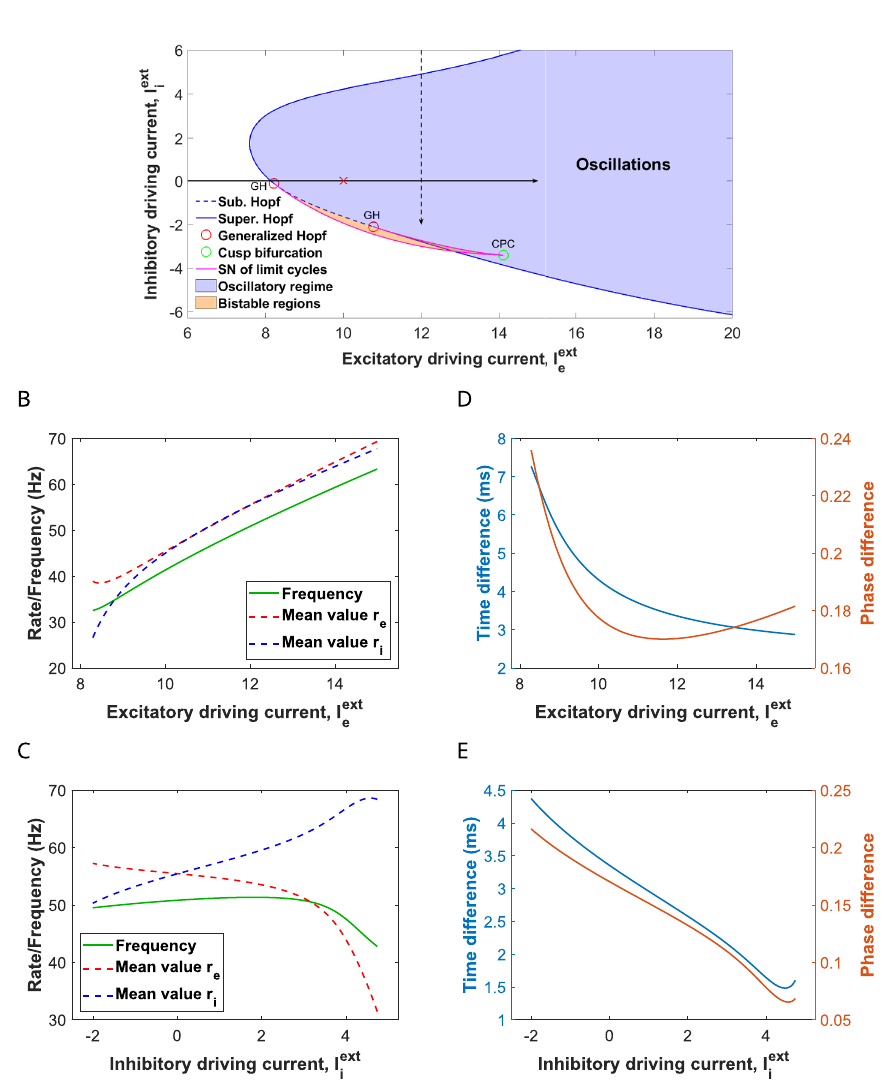
Fig 2. E-I cortical network with oscillatory activity in the gamma range. (A) Two-parameter bifurcation diagram of system (1)-(2) for the excitatory current � I ext ( x -axis) and the inhibitory current � I ext ( y -axis). The solid (resp. dashed) e i blue curve corresponds to a supercritical (resp. subcritical) Hopf bifurcation curve. Red circles correspond to (codimension 2) Generalized Hopf bifurcations (GH), also known as Bautin bifurcations. Purple curve corresponds to saddle node bifurcation of limit cycles. Green circle corresponds to a Cusp bifurcation of limit cycles (CPC), a point where two branches of saddle-node bifurcations of limit cycles meet tangentially. Oscillations occur in the blue and orange regions. Red cross corresponds to values � I ext ¼ 10 and � I ext ¼ 0 generating the limit cycle considered later on. e i (B, C) Frequency oscillation (green) and integral mean values of the firing rates r e (dashed red) and r i (dashed blue) as a function of (B) tonic excitatory current � I ext and (C) tonic inhibitory current � I ext . See Eq (7). (D, E) Time difference e i (blue) and relative phase (orange) between inhibition and excitation as a function of (D) tonic excitatory current � I ext e and (E) tonic inhibitory current � I ext . In Panels B and D the inhibitory current � I ext is set to 0. In Panels C and E the tonic i i excitatory current � I ext is set to 12. Other parameters are as in (6). e